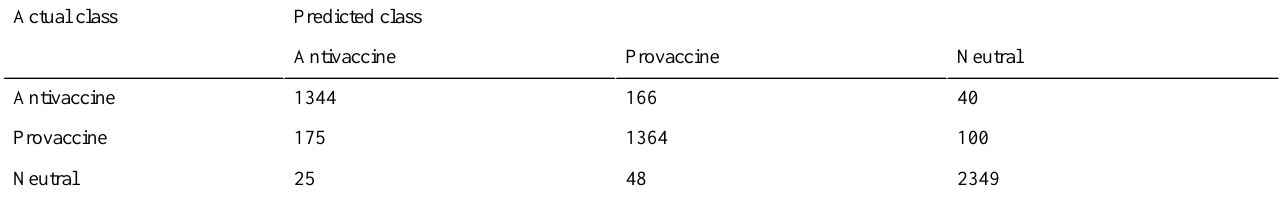
Table 1. Confusion matrix for the three classes of